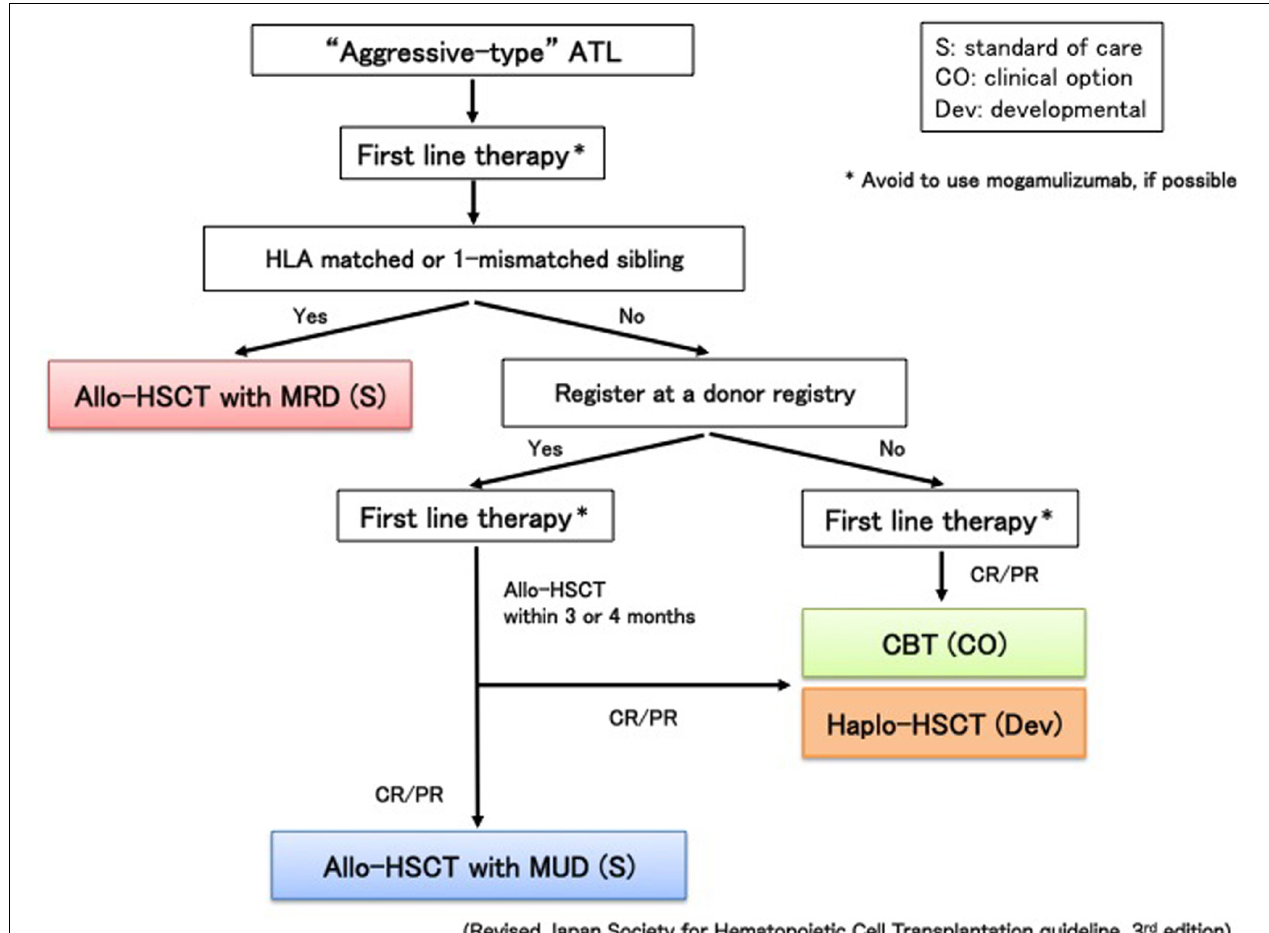
FIGURE 1 | Algorithm for donor selection in allo-HSCT. Match-related donor (MRD), hematopoietic stem cell transplantation (HSCT) and cord blood transplantation (CBT).